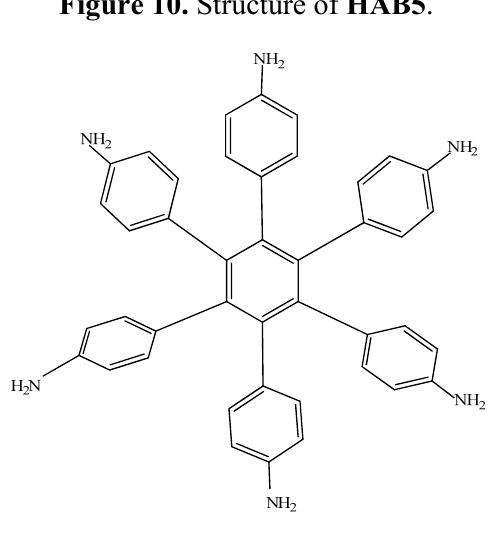
Figure 10. Structure of HAB5